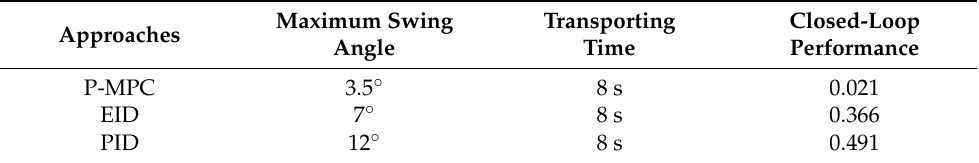
Figure 6. Result of Case 2. Table 1. The Comparison of the Three Approaches for Case 1.